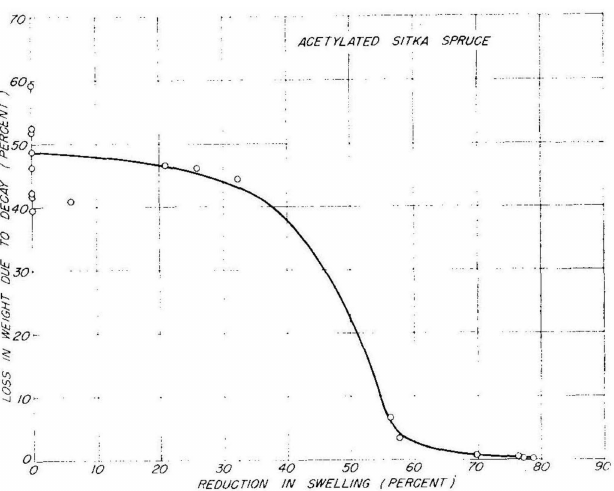
Figure 8. Relationship between the loss in weight due to decay and reduction in swelling of acetylated Sitka spruce with 1% zinc chloride as a catalyst